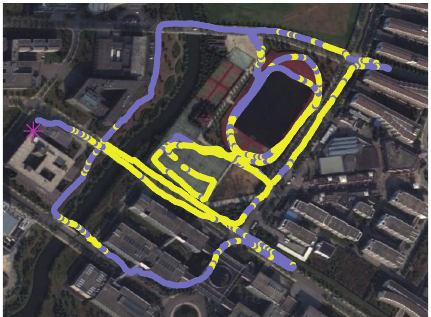
Figure 15: The map of the environment, the location of the Tx antenna, and the routes along which the Rx moves during the measurements.